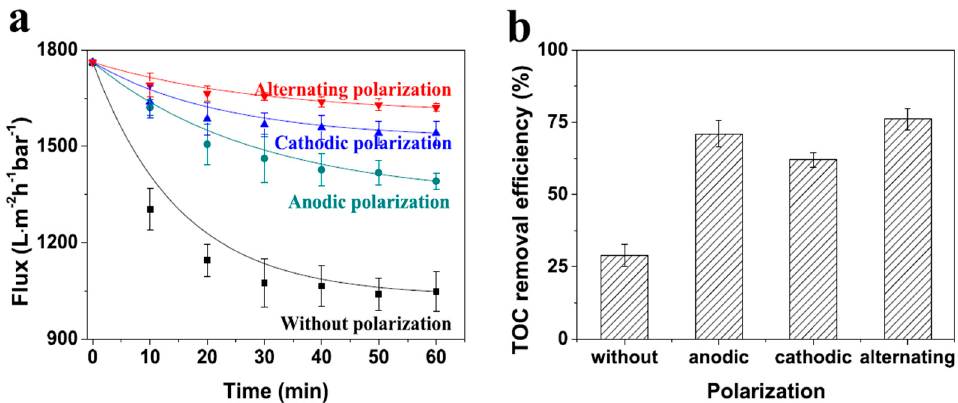
Figure 16. Effect of different types of electrochemical stimulation on the performance of an MWNT/ceramic membrane during filtration experiments performed using solutions containing natural organic matter: ( a ) Effect on normalised permeate flux of water; ( b ) Effect on TOC removal efficiency. Reproduced with permission from Reference [125]. Copyright Elsevier, 2015.